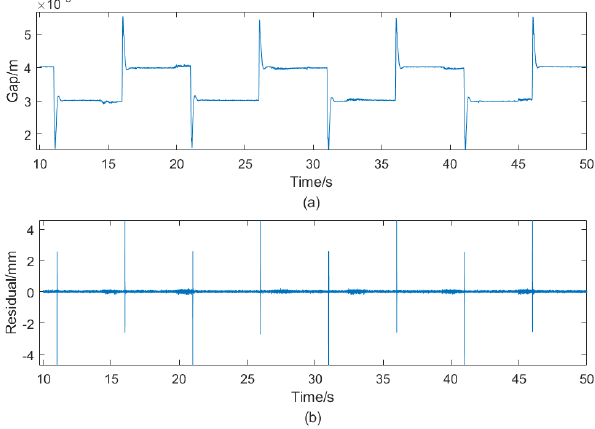
Figure 7. Gap ( a ) and residual ( b ) when the load fluctuates.